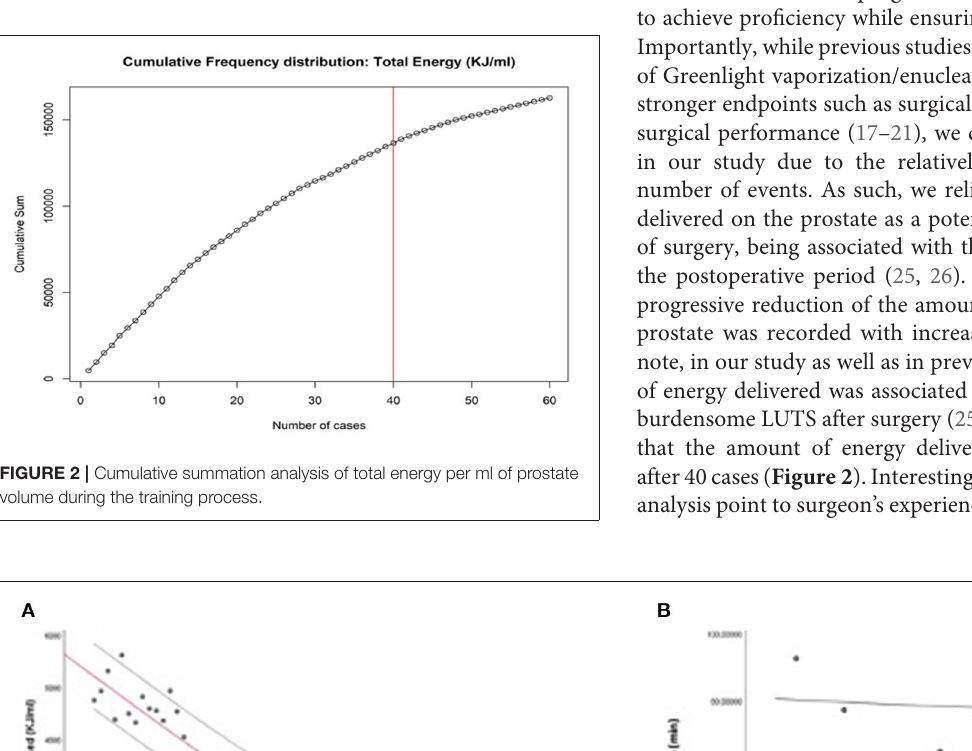
Frontiers in Surgery |